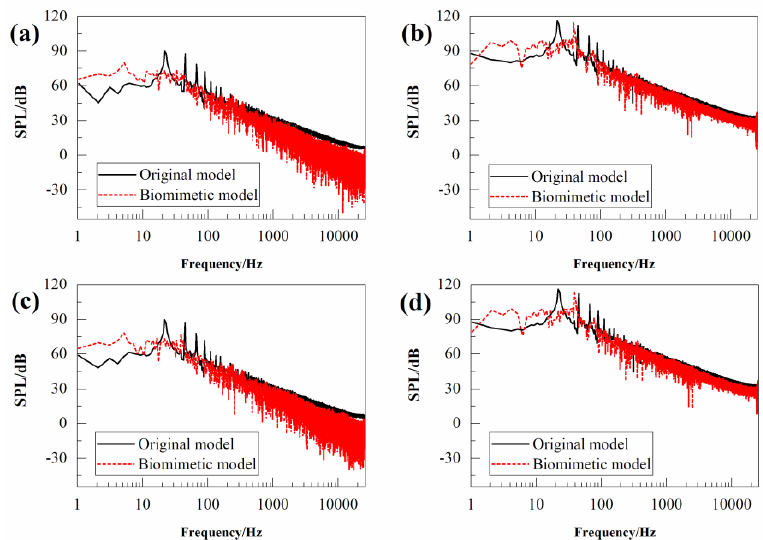
Figure 20. Comparison of the predicted SPL spectra of the original hydrofoil and biomimetic hydrofoil at the four observing points of the far sound field: ( a ) p 24 ; ( b ) p 28 ; ( c ) p 32 ; and ( d ) p 36 .